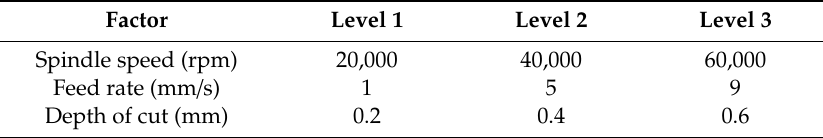
Table 1. Micromilling parameters for temperature e ff